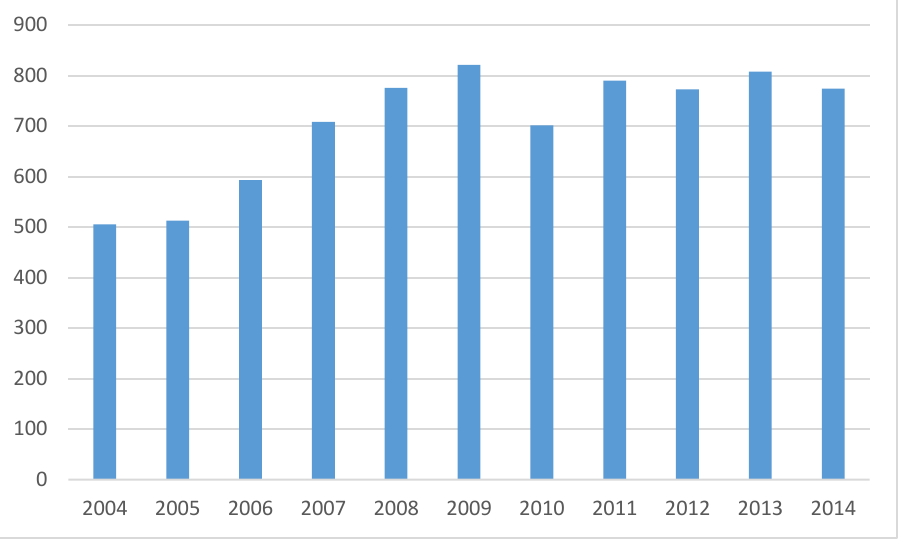
Figure 1. Frequency of migraine admissions by year in Finland.